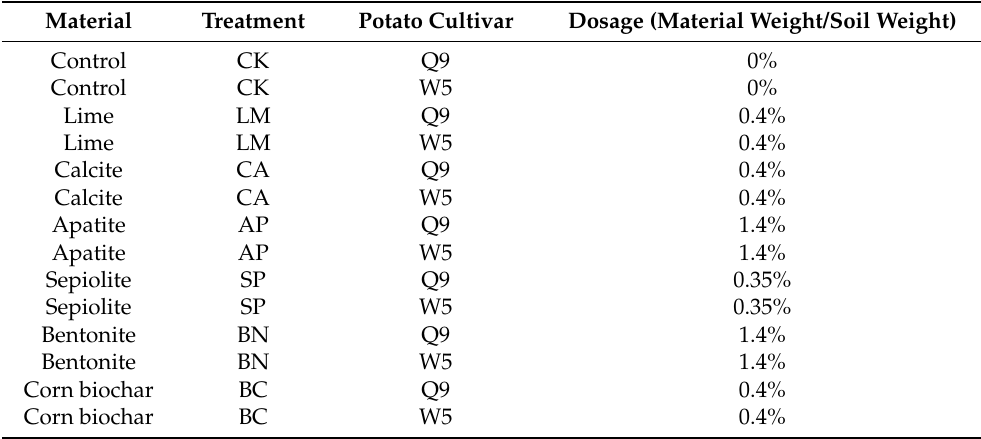
Table 1. Pot experiment treatment.